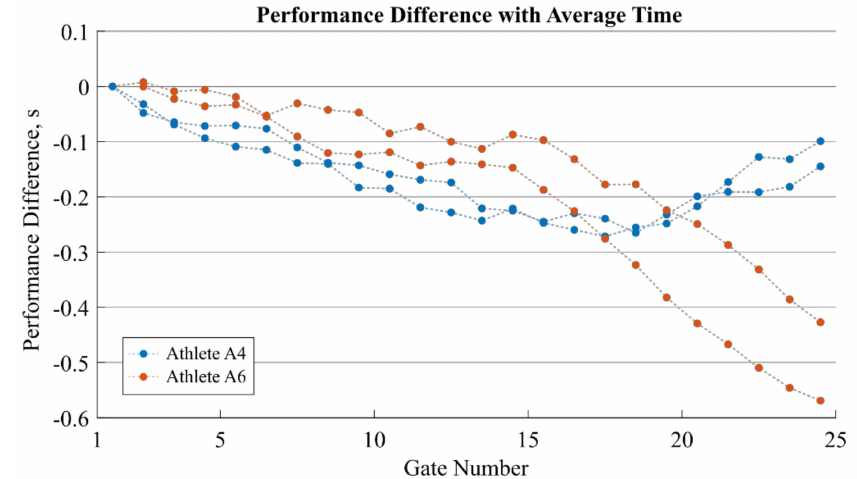
Figure 5. Performance gain/loss analysis compared to average group performance. The cumulated performance difference to average group performance is shown for the two runs of athlete A4 (in blue) and A6 (in orange). Both athletes were faster than the group average. Each dot corresponds to one gate-to-gate time measurement where the value at position i + 0.5 refers to the gate-to-gate performance difference between gates i and i + 1. A negative performance means that the athlete was faster than the average performance. A negative slope means a gain of performance, whereas a positive slope means a loss of